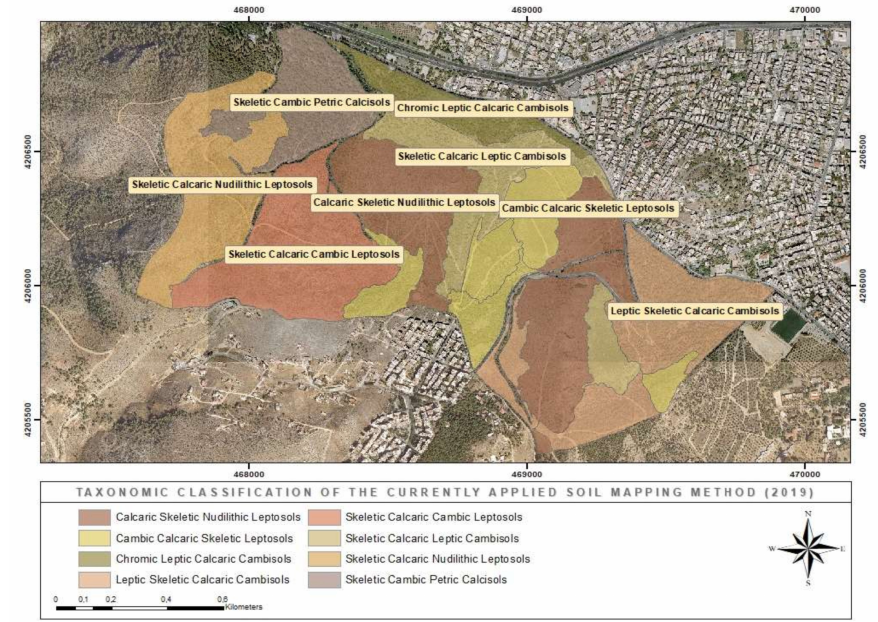
Figure 10. World Reference Base for Soil Resources (WRB) soil classification according to the currently applied mapping